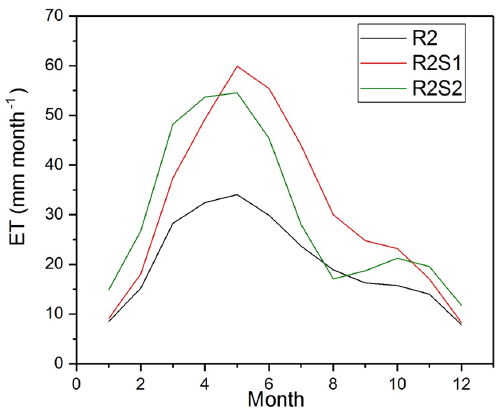
Figure 9. Comparison of ET simulations for cropland during 2000– 2009 under the R2 and R2S1